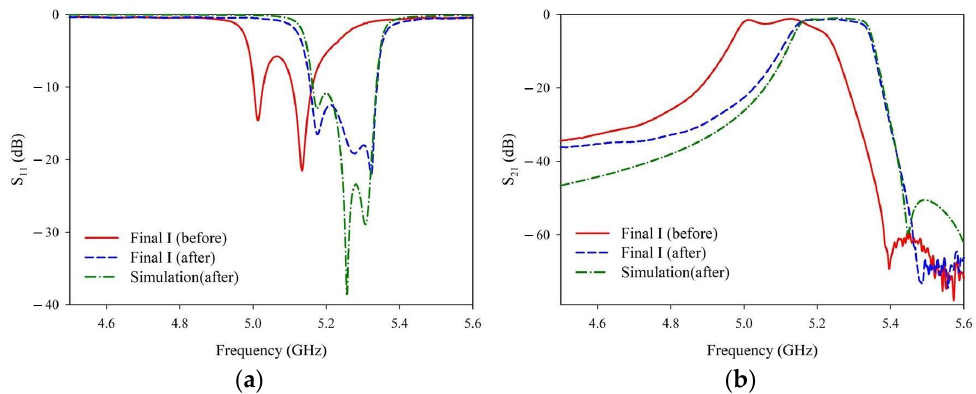
Figure 16. Measured ( a ) S 11 ( b ) S 21 values of the filter before laser trimming and after laser trimming (measurements and simulation results). Table 8. Summary of parameters before laser trimming and after laser trimming (measurements and simulation